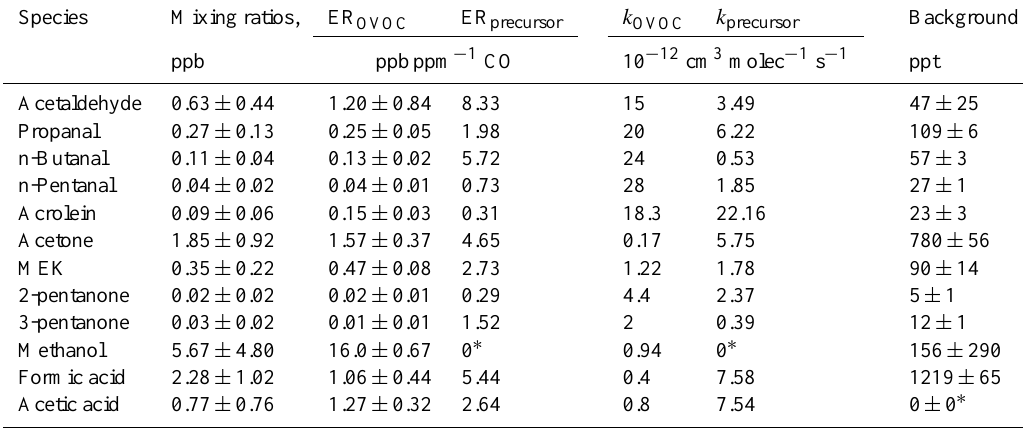
Table 2. The parameters describing OVOC concentrations at Changdao. Species Mixing